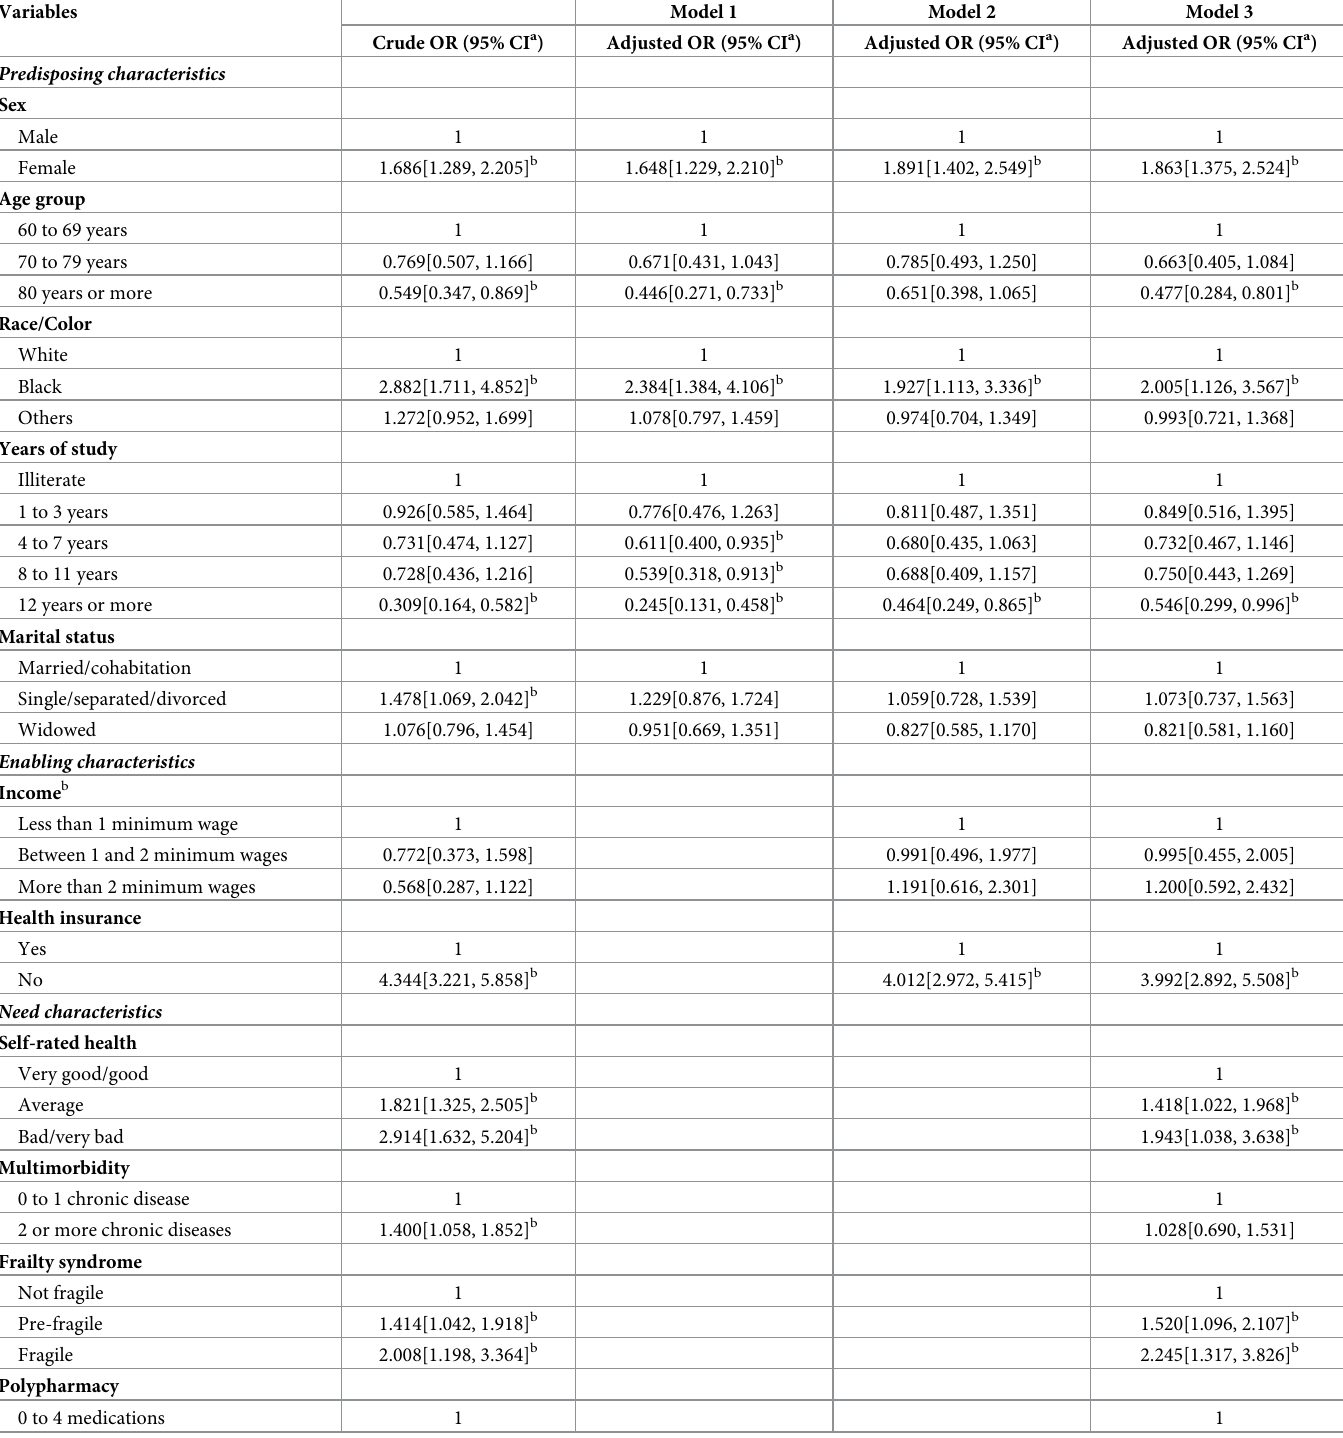
Table 2. Logistic regression in relation to the outcome difficulty in accessing health services by the elderly and associated factors. SABE Study, S ã o Paulo, Brazil,